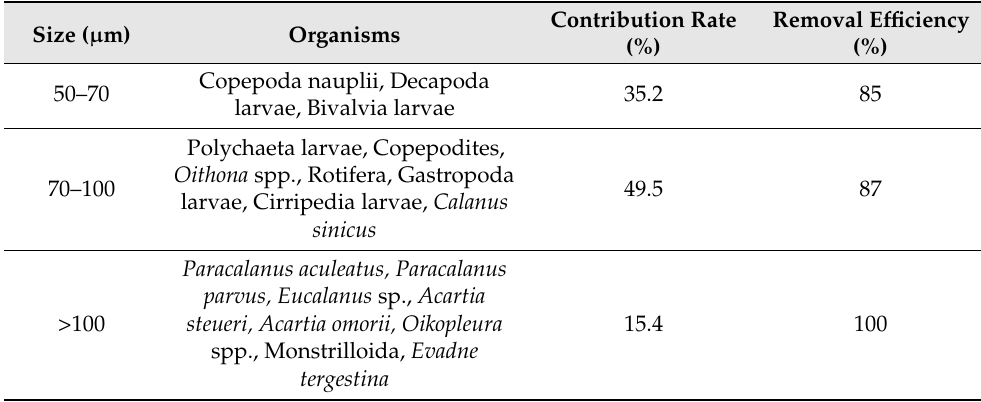
Table 8. Removal efficiency of zooplankton species treated by full-scale GE BWMS pre-treatment system according to the size different in the 1–5th test cycle.